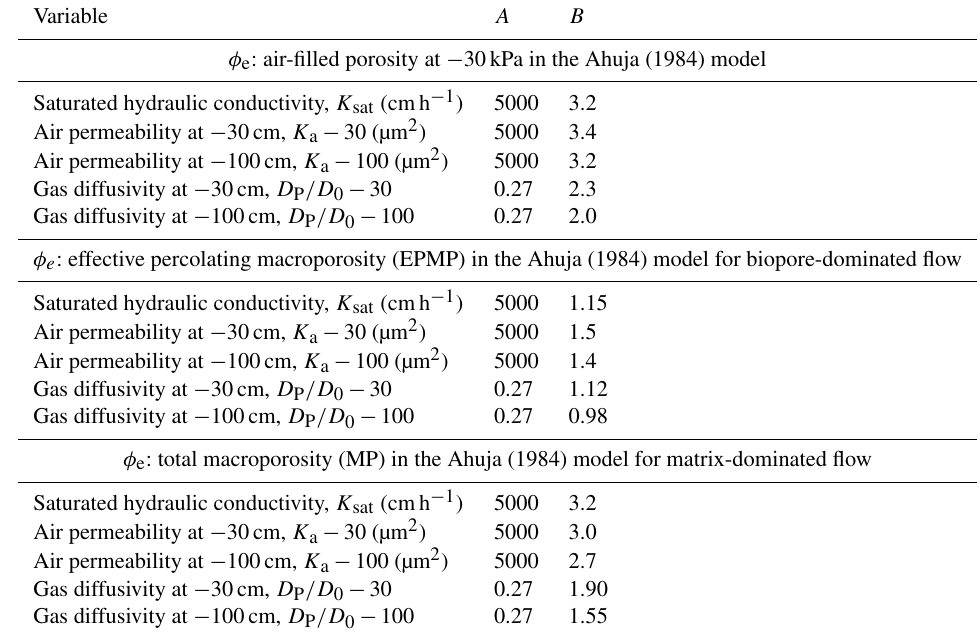
Table 3. Empirical constants for the Ahuja (1984) model with air-filled porosity at − 30kPa, X-ray CT-derived effective percolating macro- porosity (EPMP), and total macroporosity (MP) as effective porosity φ e , respectively. Variable A B φ e : air-filled porosity at − 30kPa in the Ahuja (1984) model Saturated hydraulic conductivity, K sat (cmh − 1 ) 5000